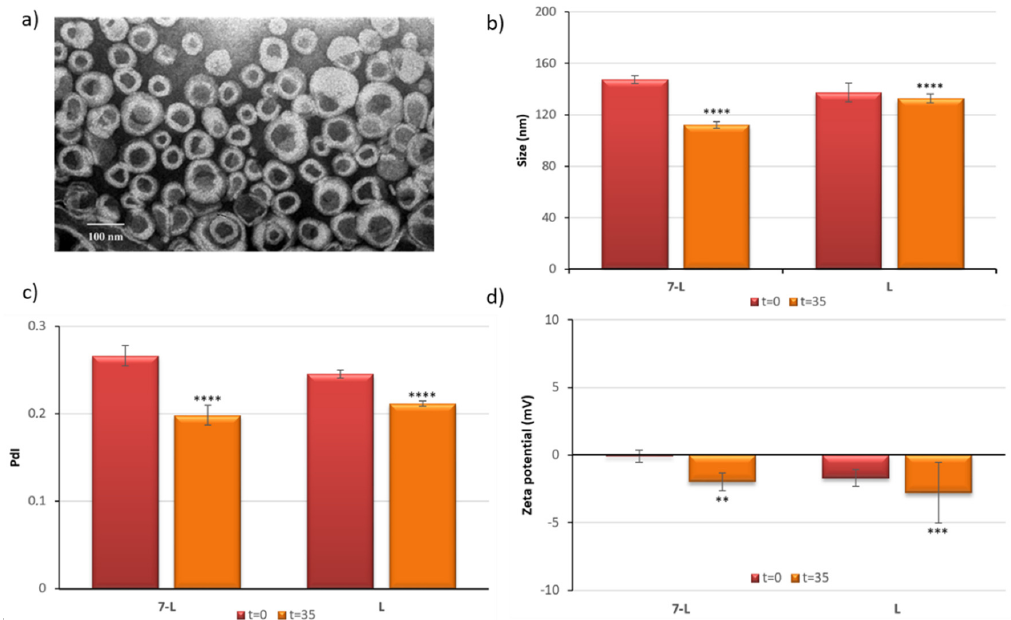
Figure 2. Transmission electron microscopy image of 7-L liposomes ( a ), changes of size ( b ), polydispersity index (PdI; c ) and zeta potential ( d ) of the (7) loaded liposomes (7-L) and control liposomes (L) just after preparation (t = 0 days) and stored at 4 °C for 35 days. A star (*) show the statistical significance, where ∗ p < 0.05, ∗∗ p < 0.01 and ∗∗∗∗ p < 0.0001 are significantly different from time 0.